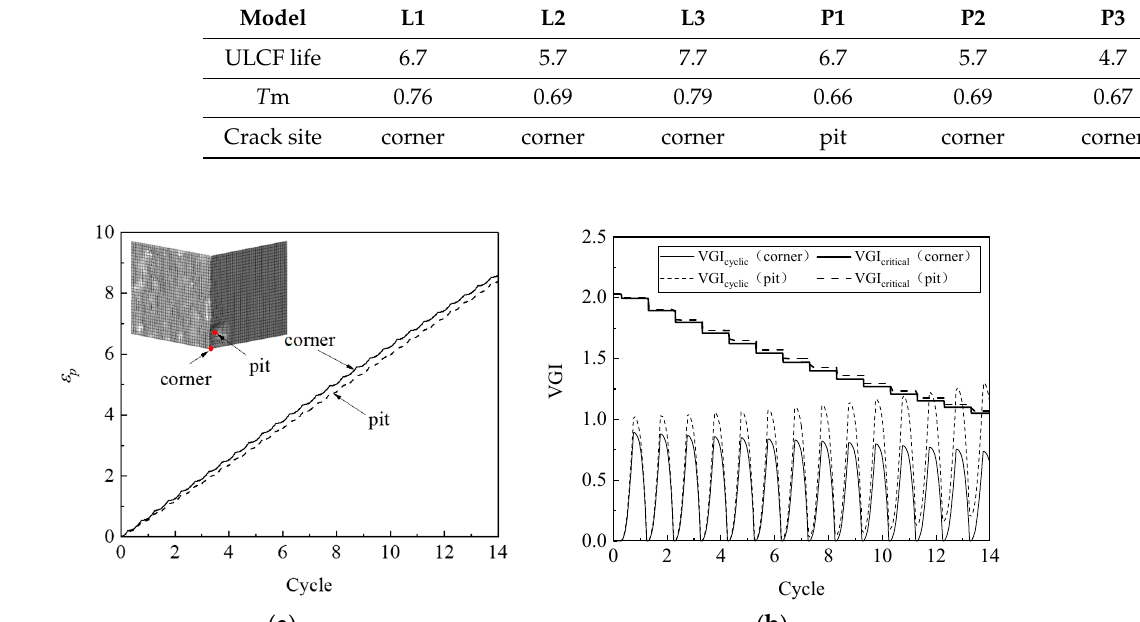
Figure 17. Comparison of ε p , VGI cyclic , and VGI critical at the corner and corrosion pit of pier P1: ( a ) ε p ; ( b ) VGI cyclic and VGI critical.